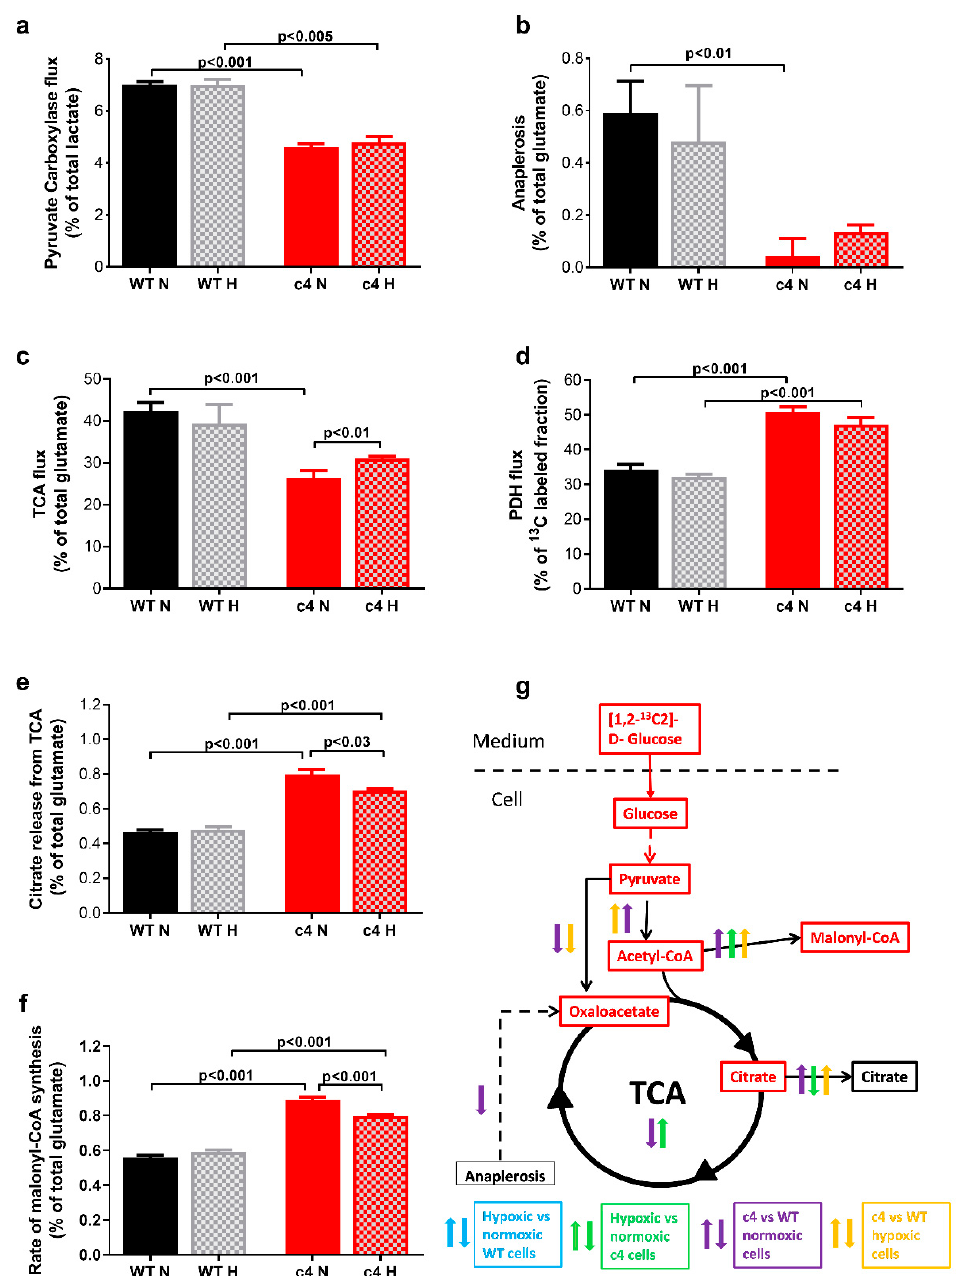
Figure 3. TCA cycle and related fluxes inferred from labelling patterns of 13 C glutamate in Hepa-1 cells. HIF-deficient cells show: ( a ) reduced PC flux (oxaloacetate formation from pyruvate via pyruvate carboxylase; M4_m/z198). ( b ) reduced anaplerotic flux through the TCA cycle (ratio of pyruvate carboxylation to TCA cycle flux). ( c ) reduced TCA flux (fewer completed TCA cycles, M2, m2_m/z 152-m3_m/z 198). ( d ) increased PDH flux (M2, C2-C4 fragments, m/z 198) ( e ) increased release of citrate from the TCA cycle via the citrate shuttle (glutamate in equilibrium with citrate and α -ketoglutarate, m/z 198). ( f ) increased rate of new malonate synthesis and fatty acid production. ( g ) Diagram showing flux differences and changes between the two Hepa-1 cell types in normoxia and hypoxia. N, normoxia; H, hypoxia (1% O 2 ), arrows pointing upwards suggest significant increase for a given comparison. Indicates differences in metabolic flux ( ↑ increased flux; ↓ decreased flux) due to HIF deficiency and hypoxia, which were inferred from changes in the relevant 13 C-labelled isotopomers. Panels ( a – f ) show data expressed as mean ± SEM ( n = 4, 3 technical replicates), statistical significance assessed by unpaired two-tailed t